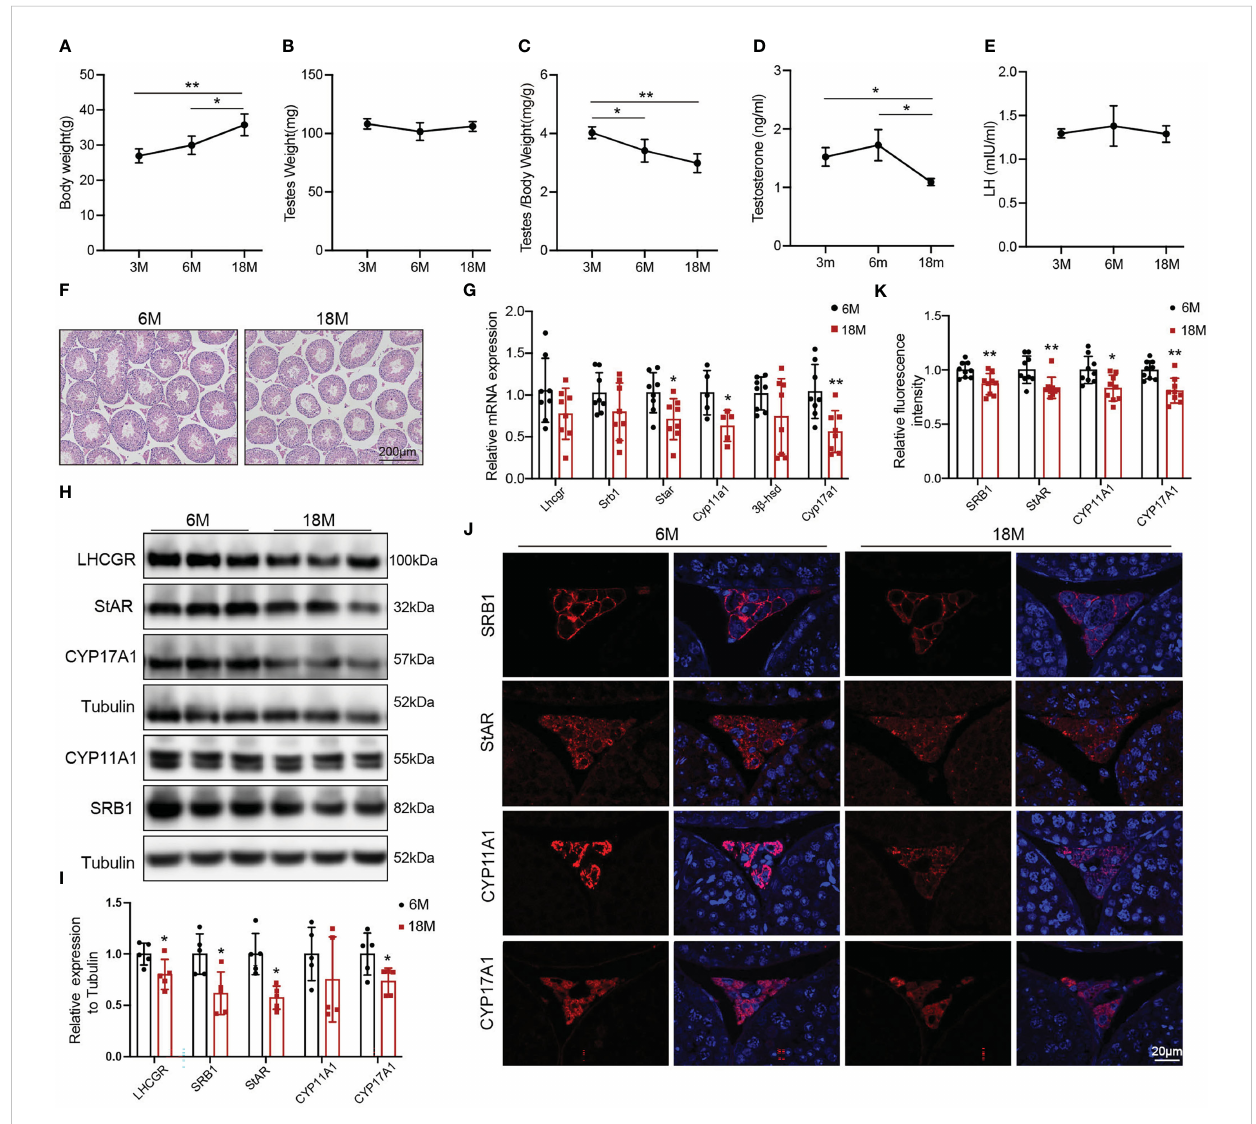
FIGURE 1 General features and testosterone synthesis of young and aged mice. (A) Body weight. (B) Testis weight. (C) Ratio of testis to body weight. (D, E) The levels of serum testosterone and serum luteinizing hormone (LH) were analyzed by ELISA. (F) Testis morphology was examined by HE staining. (G) The mRNA levels of proteins associated with testosterone synthesis were analyzed by Quantitative real time PCR. (H) Immunoblot assessed the protein levels of proteins related to testosterone synthesis. (I) Quantitative analyses for the protein level. (J) Immuno fl uorescence measured testosterone synthesis-related proteins. (K) Quantitative analyses of immuno fl uorescence. *p<0.05,